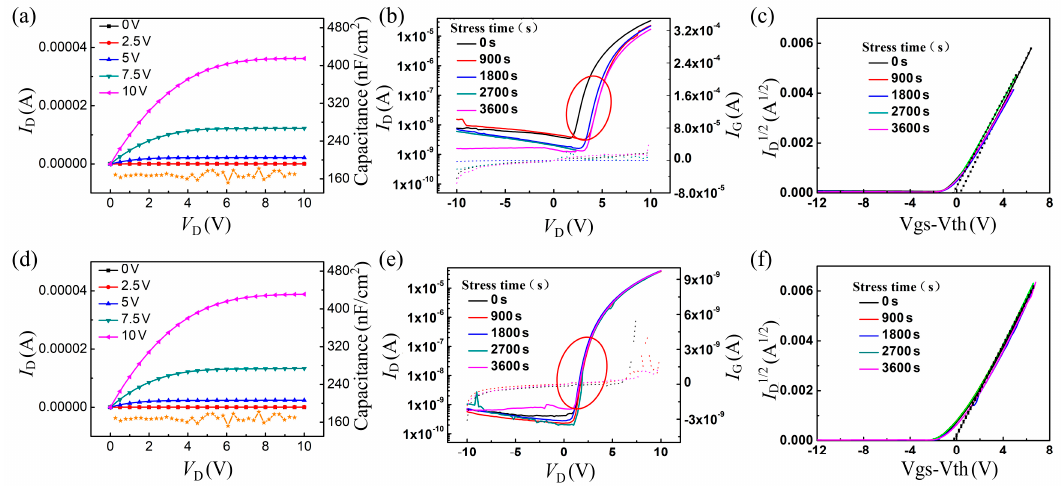
Figure 5. Bias stability of the TFT with ZrO 2 film fabricated by spin-coating of 0.3 M precursor for 6 times. ( a ) Output curves and gate capacitance as a function of voltage. ( b ) Transfer curves with gate- leakage current curves of positive bias stress. ( c ) Plots of sqrt I ds (drain/source current) versus gate overdrive of positive bias stress. ( d ) Output curves and gate capacitance as a function of voltage. ( e ) Transfer curves with gate-leakage current curves of negative bias stress. ( f ) Plots of sqrt I ds (drain/source current) versus gate overdrive of negative bias stress.